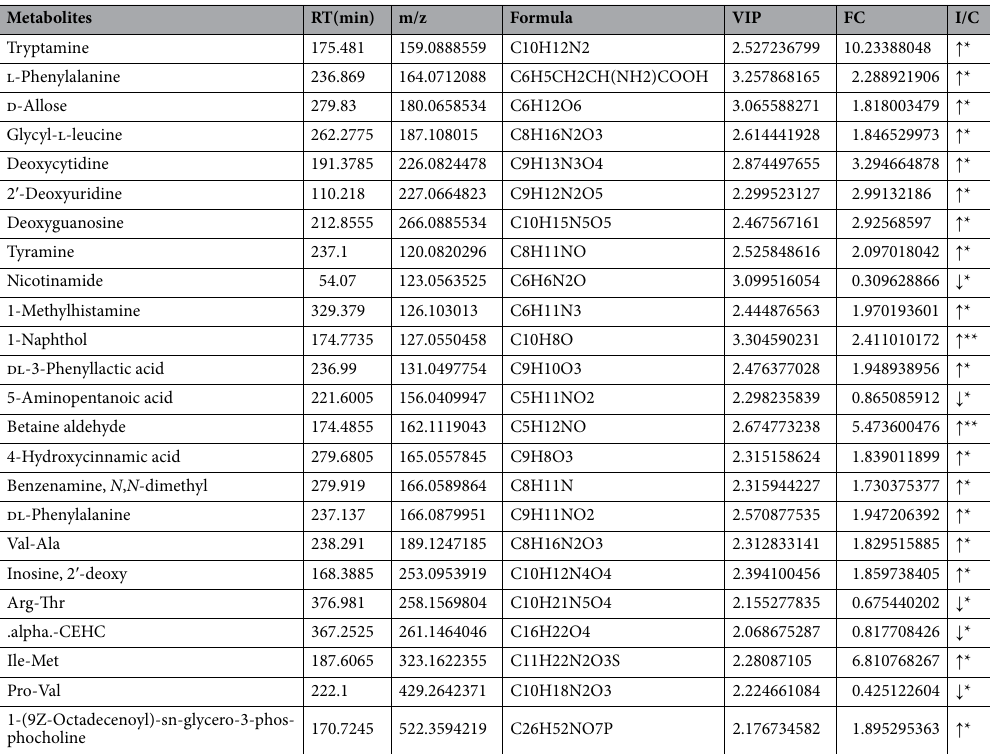
Table 2. The different metabolic profiles between the control and IBS groups. RT retention times, VIP variable importance for projection, I/C IBS group compared to controls, FC fold change. ↑ : upregulated, ↓ : downregulated; * P < 0.05, ** P <